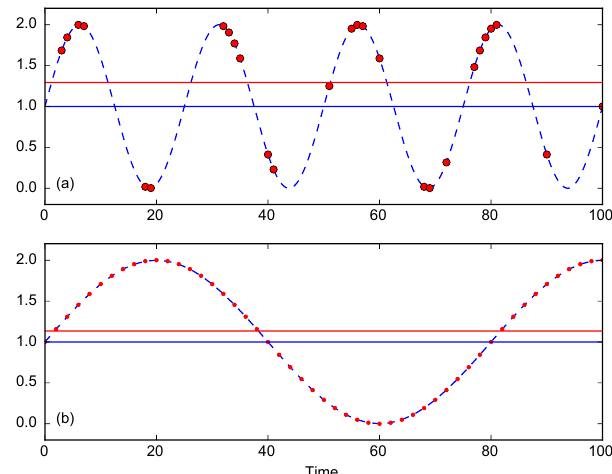
Figure 2. Signal average and sampling. (a) The continuous signal is in dashed blue and it is irregularly sampled at red dots. The continu- ous signal oscillates around 1 (blue line), which does not correspond to the average of the sampled signal (red line). (b) Same as panel (a) with a regularly sampled